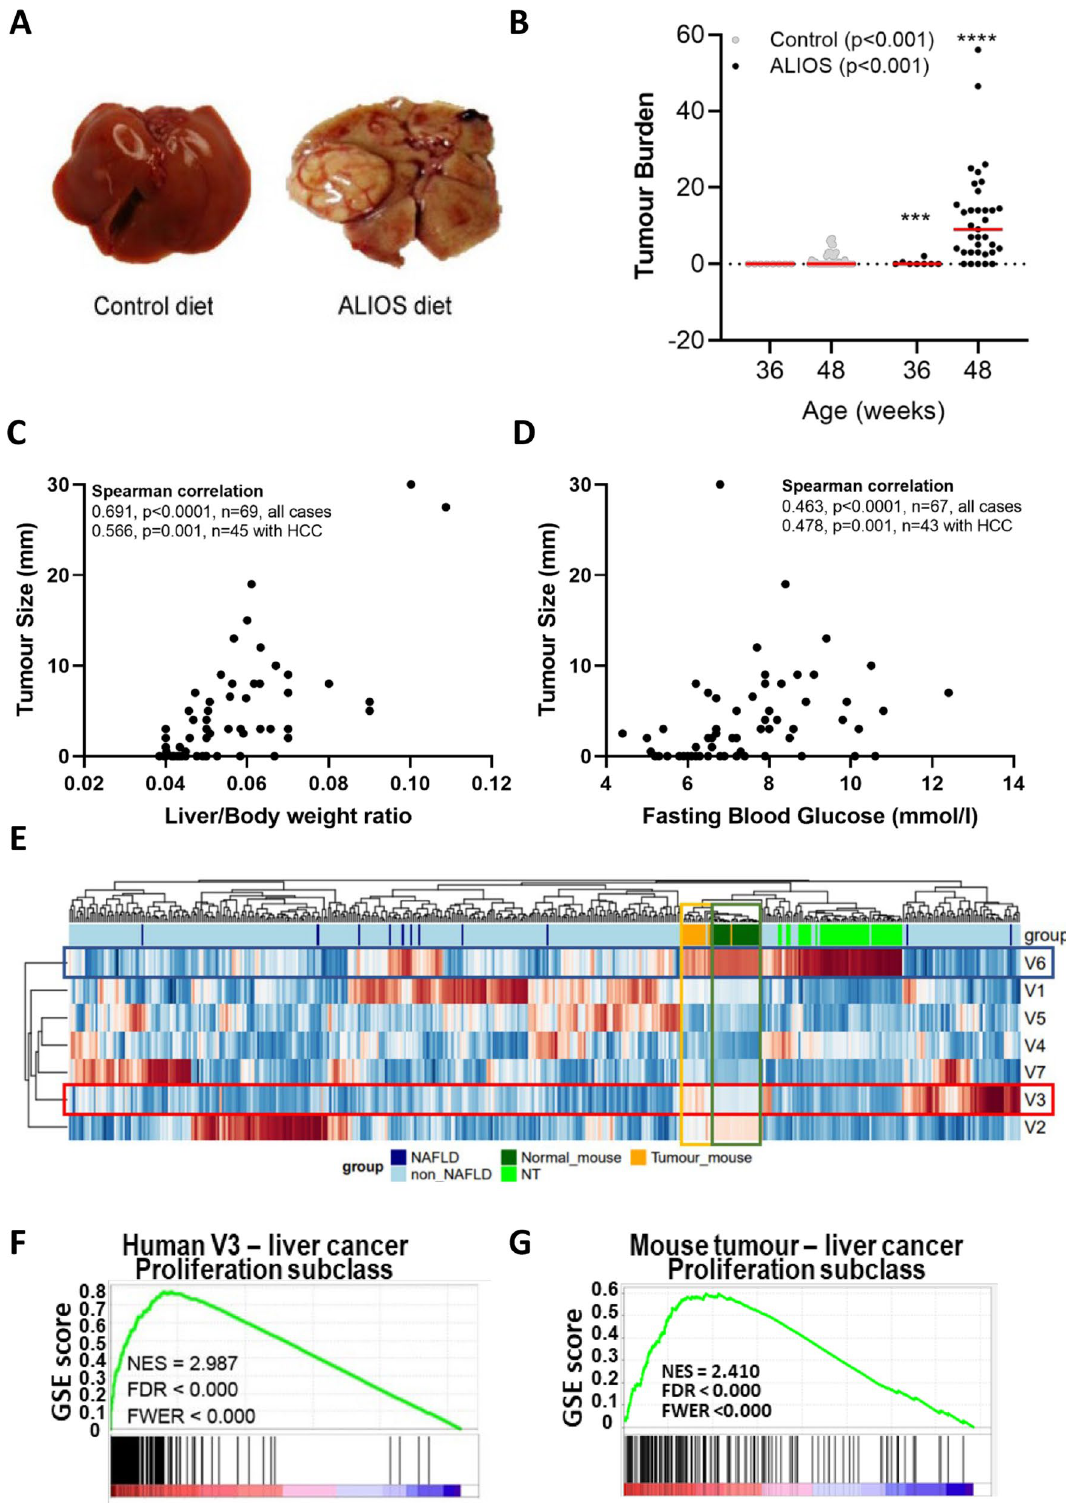
Figure 2. Aged C3H/He mice fed the ALIOS diet develop HCC. Livers of ALIOS fed mice at 48 weeks appeared steatotic with visible tumours ( A ), with elevated tumour burden ( B ) relative to control. Tumour size increased in association with liver/weight ratio (C) and fasting blood glucose ( D ). The transcriptome of mouse tumours overlapped with a distinct human subclass of HCC, comparing RNA- seq data ( E – F ). In the heat map of Non-negative Matrix Factorization (NMF) ( E ),tissue type is colour coded (top row). Red and blue represent higher and lower gene expression. The human non-tumour (NT) metagene is marked V6 (blue rectangle), with tumour (T) metagenes defined as V1–V5 and V7. A red rectangle marks the V3 human metagene. Mouse T and NT transcriptomes are shown by orange and green rectangles. A proliferative subclass was identified by the Gene set enrichment analysis (GSEA) score of top enriched dataset in human V3 (F), and the mouse T versus NT differentially expressed genes (G). Data in (B) presented as mean ± S.E.M., compared with Mann Whitney